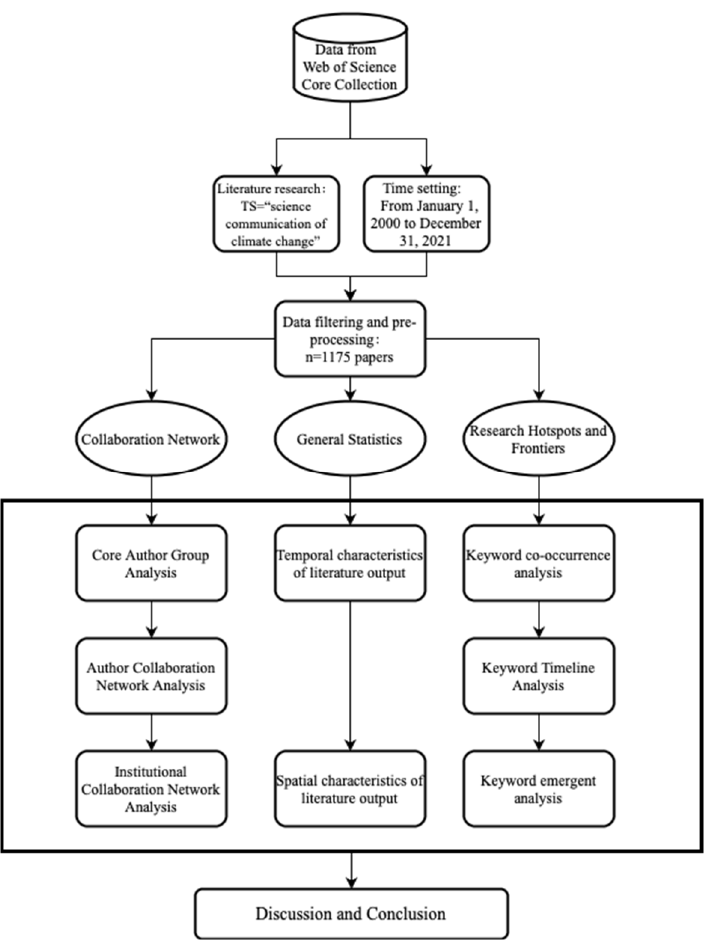
Figure 1. The integrated analysis framework.